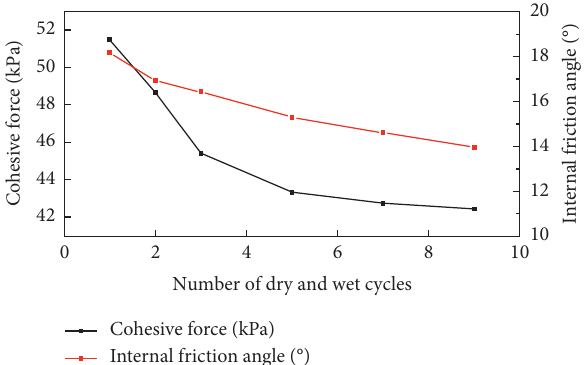
Figure 6: Shear strength parameters of red clay under different dry and wet cycles (wet for